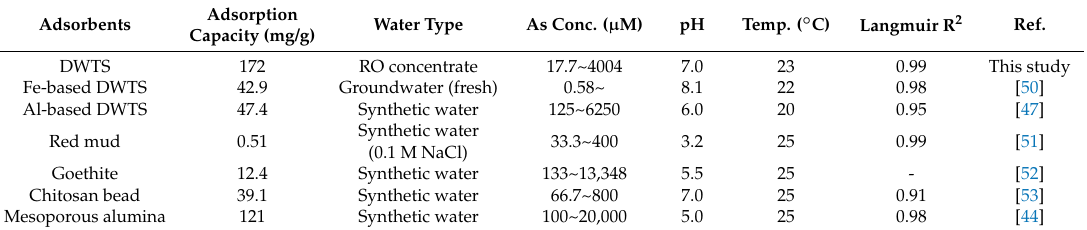
Table 3. Sorption capacity of unconventional adsorbents under different testing